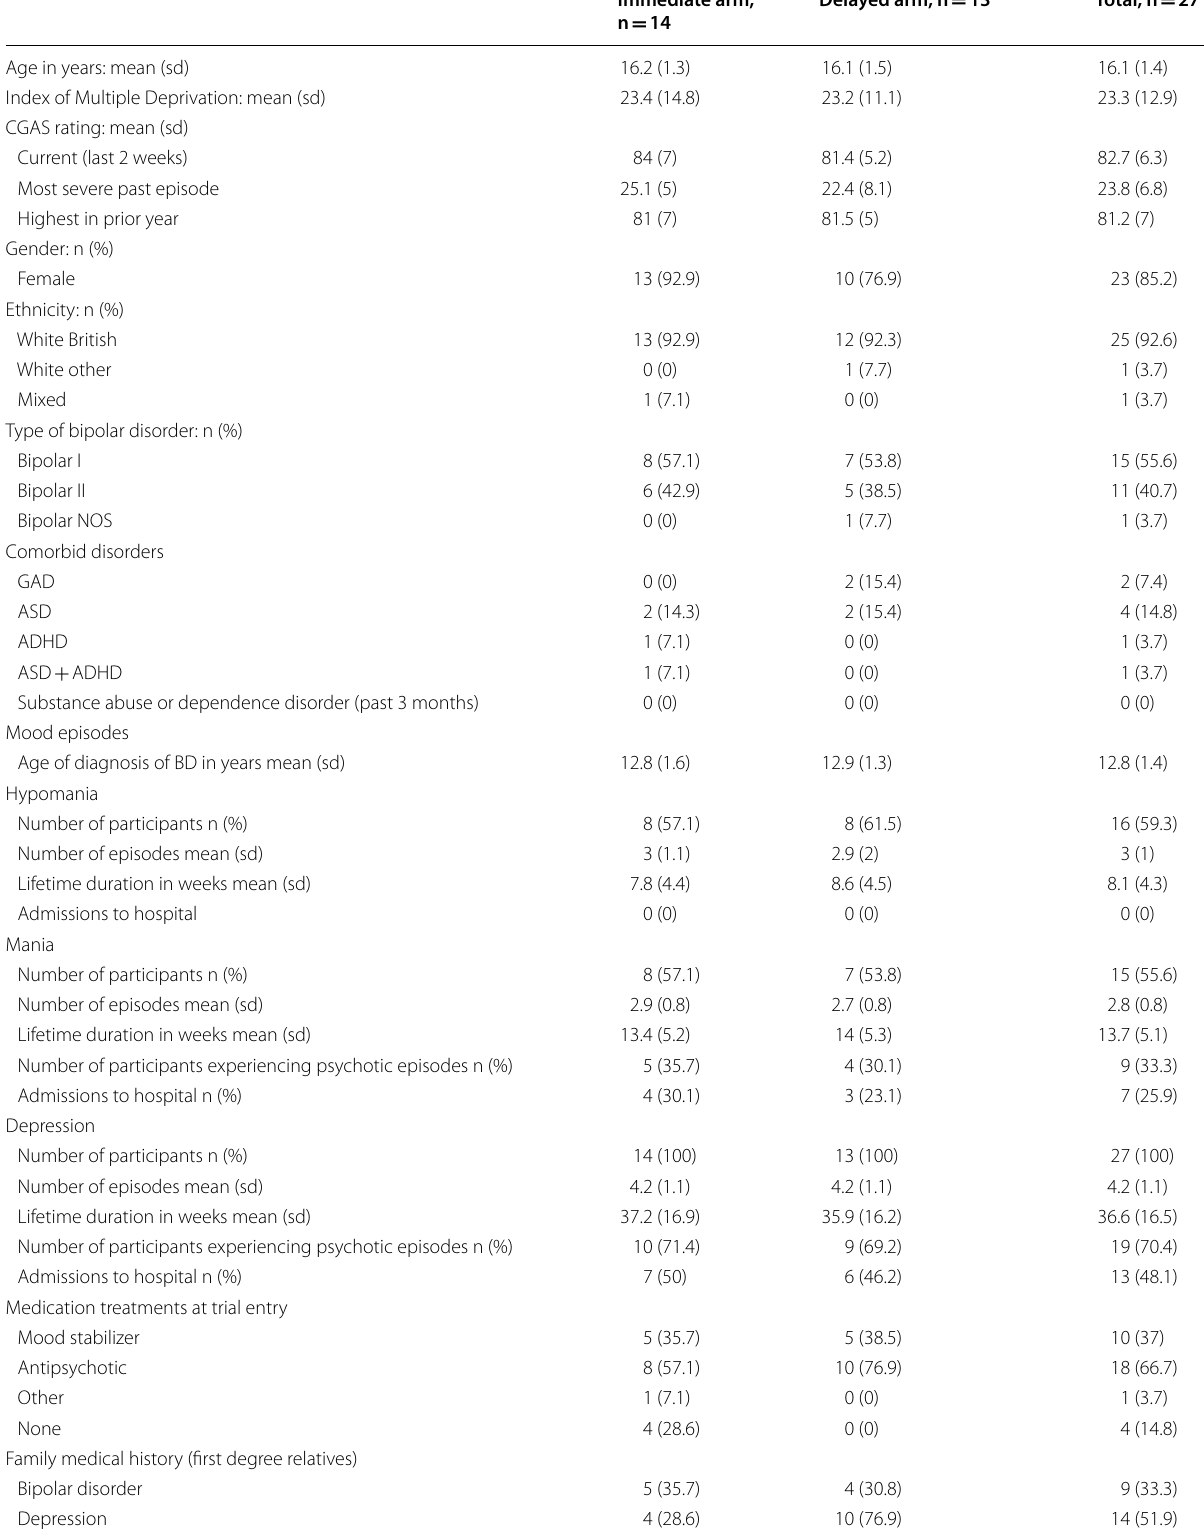
Table 1 Participant & family demographic and clinical characteristics at recruitment